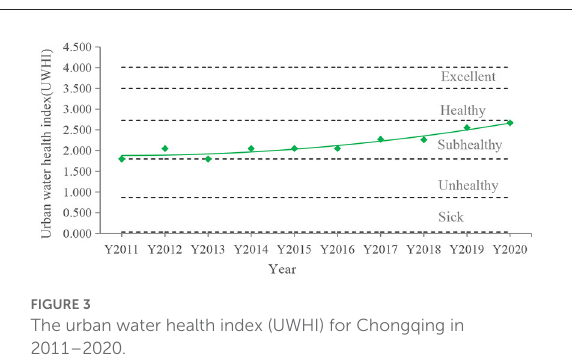
FIGURE3 The urban water health index (UWHI) for Chongqing in 2011–2020.